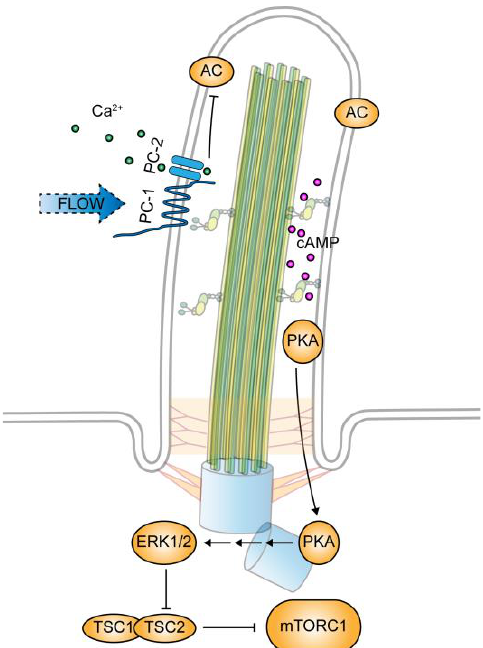
Figure 3. Regulation of mTORC1 by polycystin-1. Polycystin-1 (PC-1) functions as a mechanosensory protein in primary cilia. Flow stress that bends cilia activates PC-1, which in turn stimulates PC-2-mediated calcium influx into the ciliary compartment. The increased ciliary calcium level inhibits cilium-localized adenylyl cyclases (AC) and reduces the cyclic adenosine monophosphate (cAMP) level within the ciliary compartment. The cessation of flow stress or PC-1 dysfunction blocks the calcium entry and reduces the ciliary calcium level. Consequently, adenylyl cyclase activity increases and drives the ciliary cAMP level high, which activates PKA, leading to mTORC1 downregulation through the ERK1/2 and Tsc2 signaling cascade.